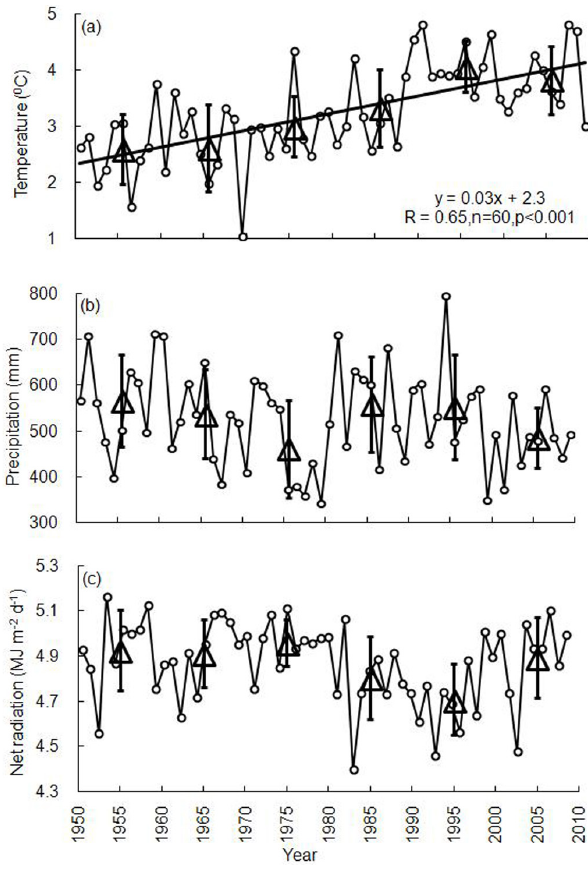
Fig. 3. Uncertainty analysis of CH 4 fluxes from marshland and rice paddies on the Sanjiang Plain.